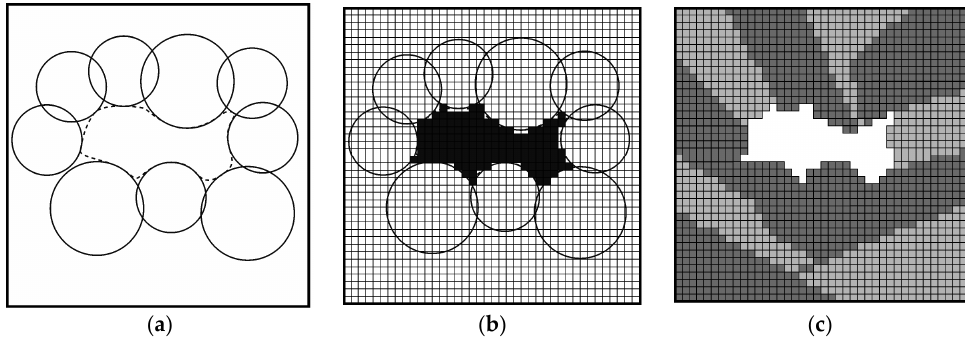
Figure 5. Modeling of pores with concave boundaries (schematic): ( a ) Approximation of the pore geometry (dashed line) by placing overlapping spheres along the pore perimeter; ( b ) Grid discretization of the inter-sphere domain; ( c ) Elimination of the corresponding elements from the voxel mesh of the grain microstructure.